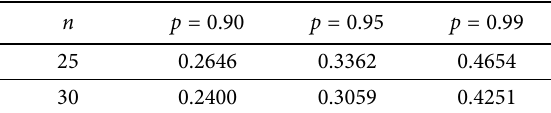
Table 5. The critical values of complete independence in Spearman’s correlation (Zwillinger